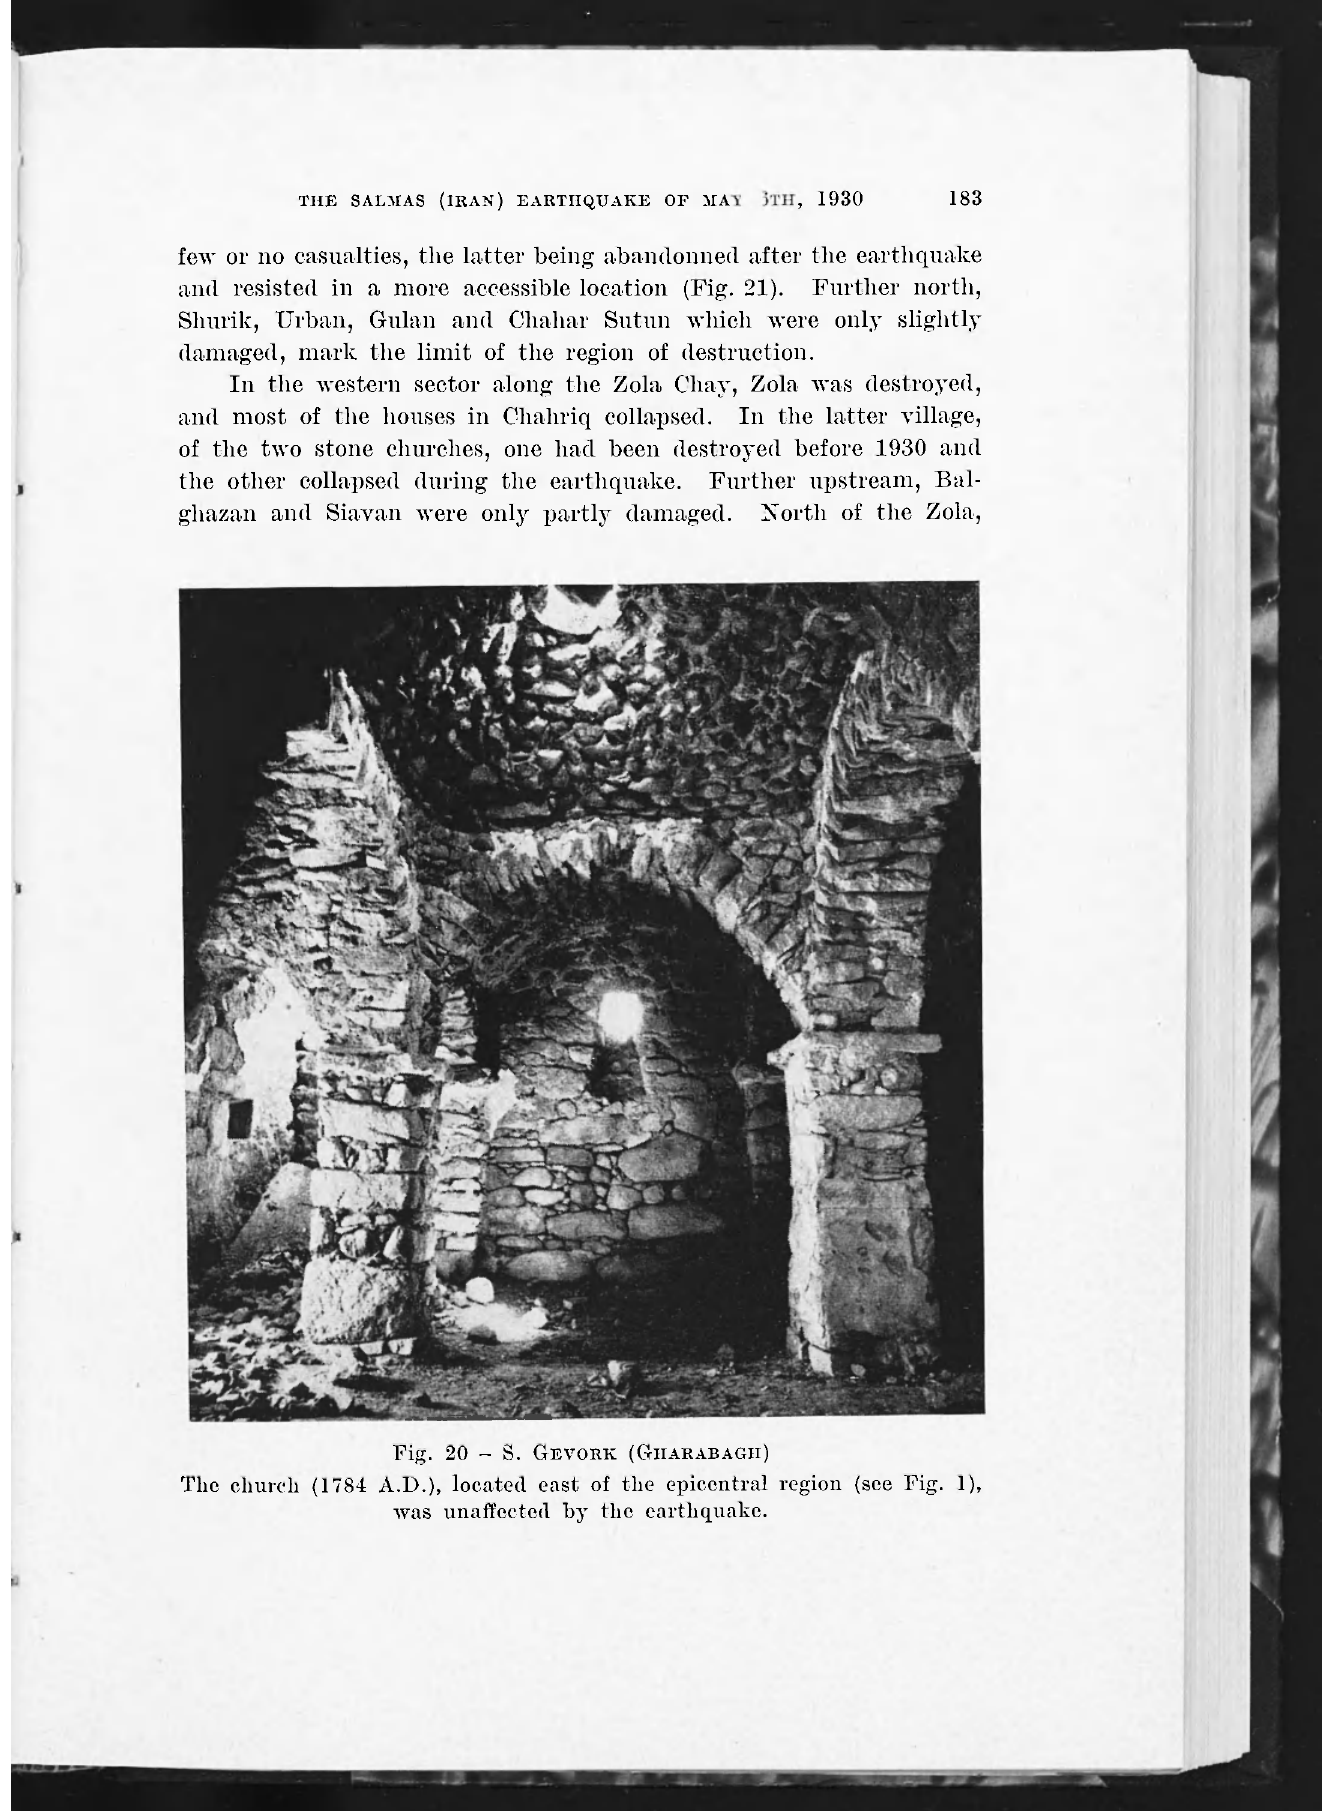
Fig. 20 - S. GEVORK